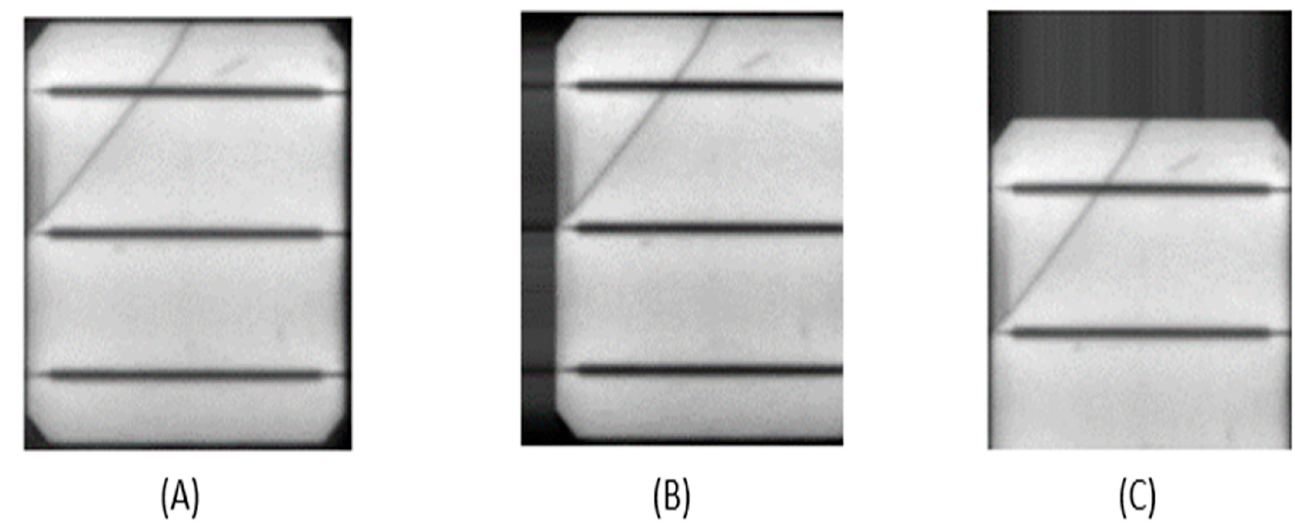
Figure 4. Pixel-based shifting ( A ) input ( B ) width shift ( C ) height shift.